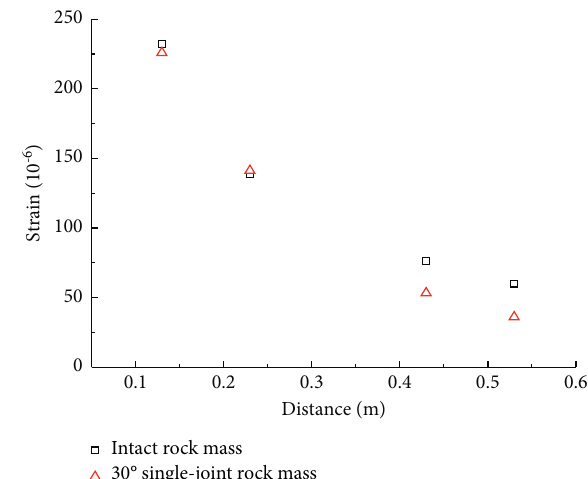
Figure 21: Attenuation law of cylindrical wave in the intact and 30 ° single-joint rock mass without confining